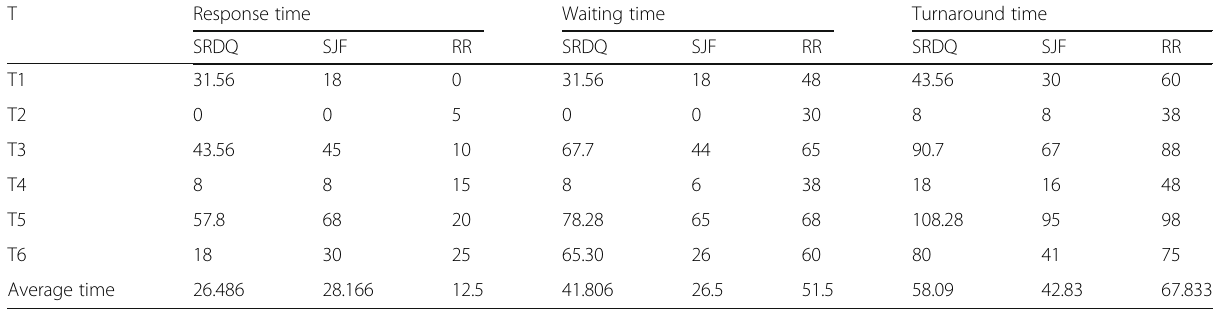
Table 5 The response, waiting and turnaround times of the SRSQ compared to SJF and RR T Response time